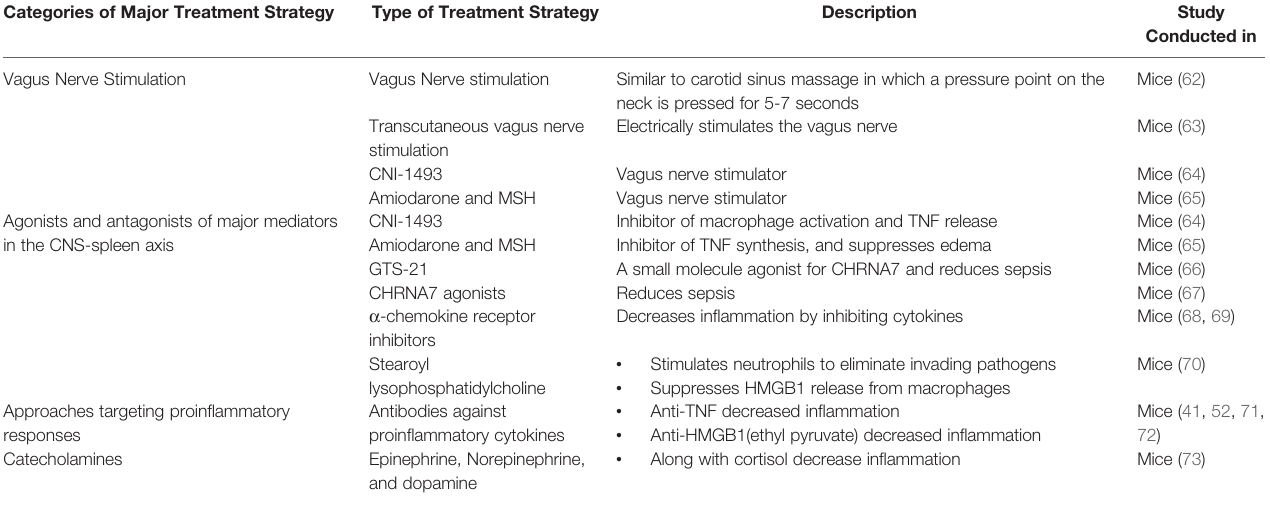
TABLE 1 | Techniques for the treatment of Burn induced Sepsis and in fl